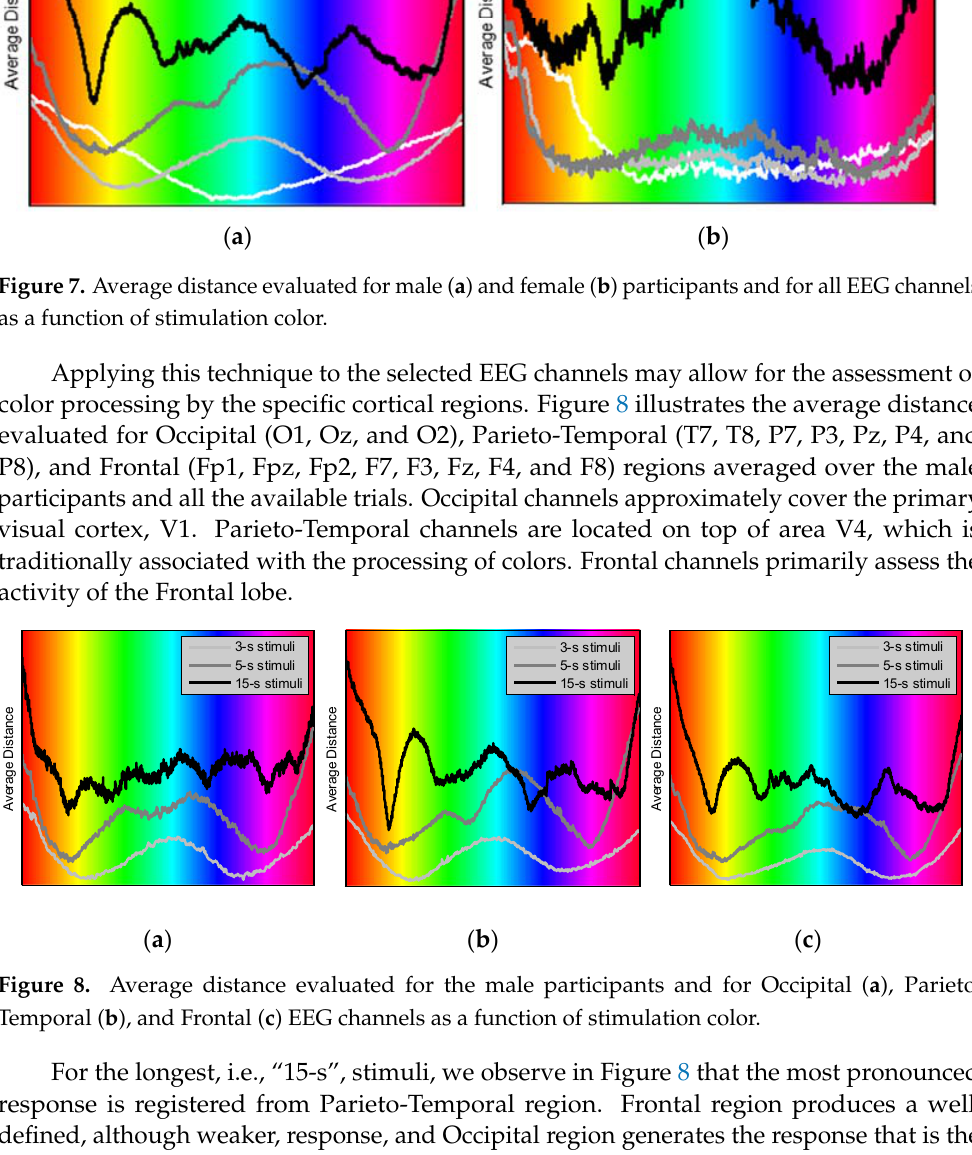
( b ) Figure 9. Average distance evaluated for the male participants and for the left ( a ) and right ( b ) Parieto ‐ Temporal EEG channels as a function of stimulation color. We see in Figure 9 that the average distance evaluated for the right hemisphere shows less variation and better pronounced local extrema; therefore, the right hemi ‐ sphere appears to produce a stronger response to color stimulation. Before proceeding with the statistical analysis, it may be worth assessing the type of statistical distribution of the analyzed data. Figure 10 illustrates histograms evaluated for the distance estimated for the EEG spatial vectors corresponding to the “3 ‐ s”, “5 ‐ s”, and “15 ‐ s” stimuli for all the male participants, all the EEG electrodes, and all post ‐ stimuli latencies.